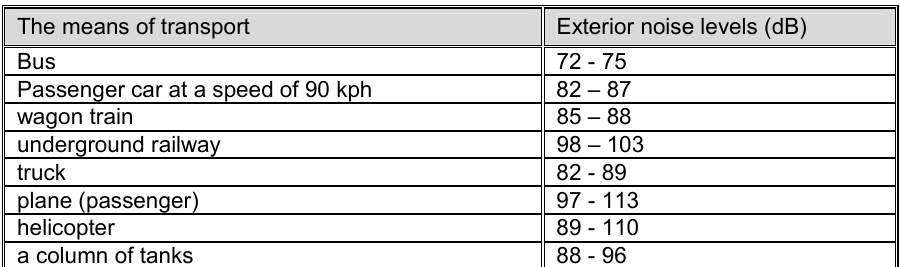
Table 3 – Noise levels of means of transport Таблица 3 – Уровень шума дорожно - транспортных